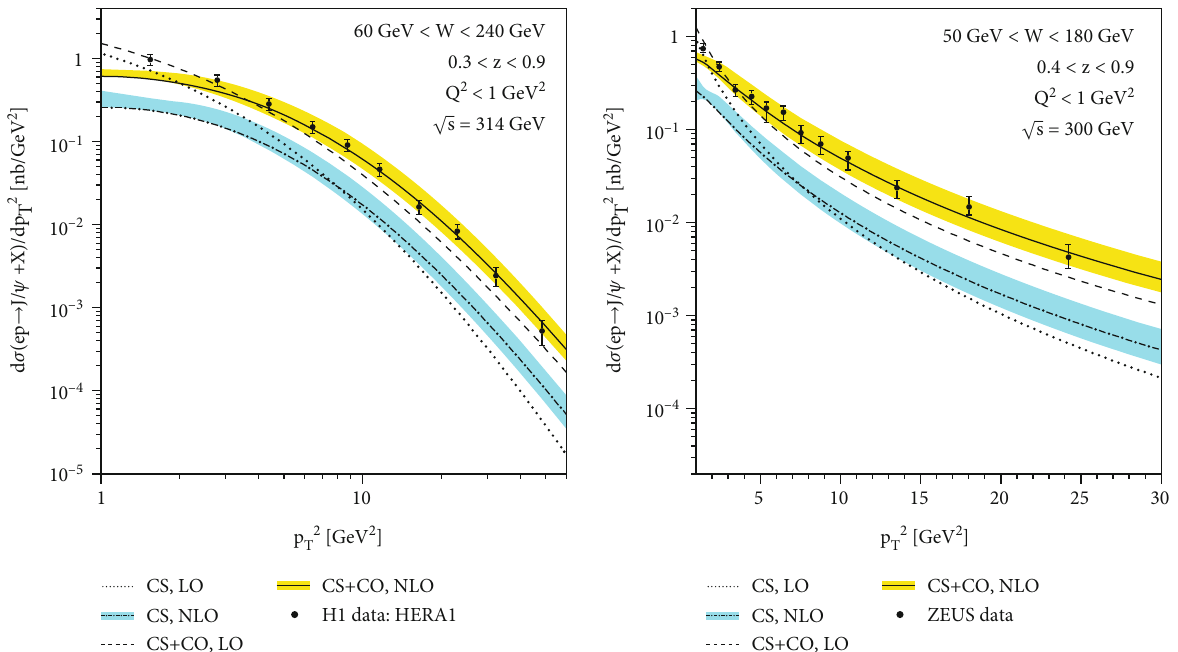
Figure 8: NLO NRQCD calculation compared to HERA data. Figures taken from Ref. [160].